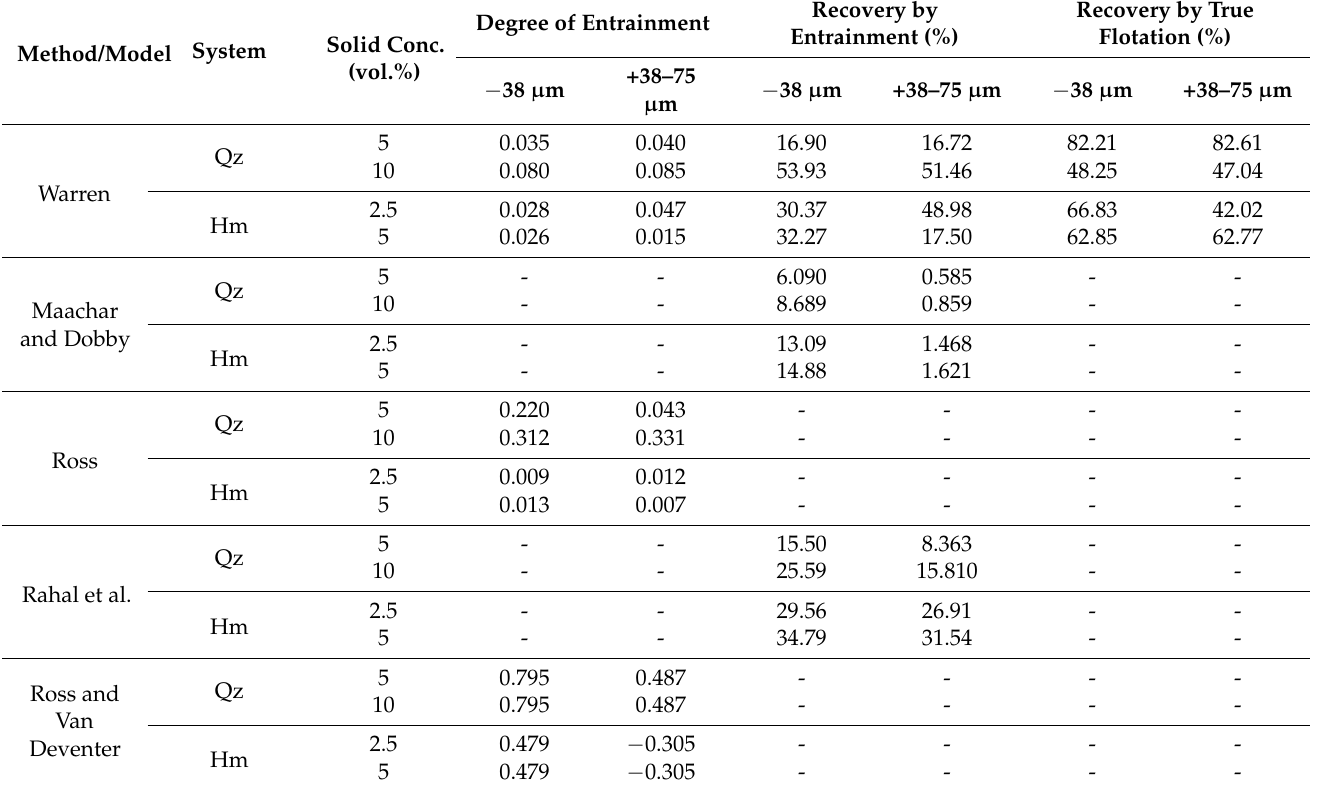
Table 5. Numerical values of the tested entrainment